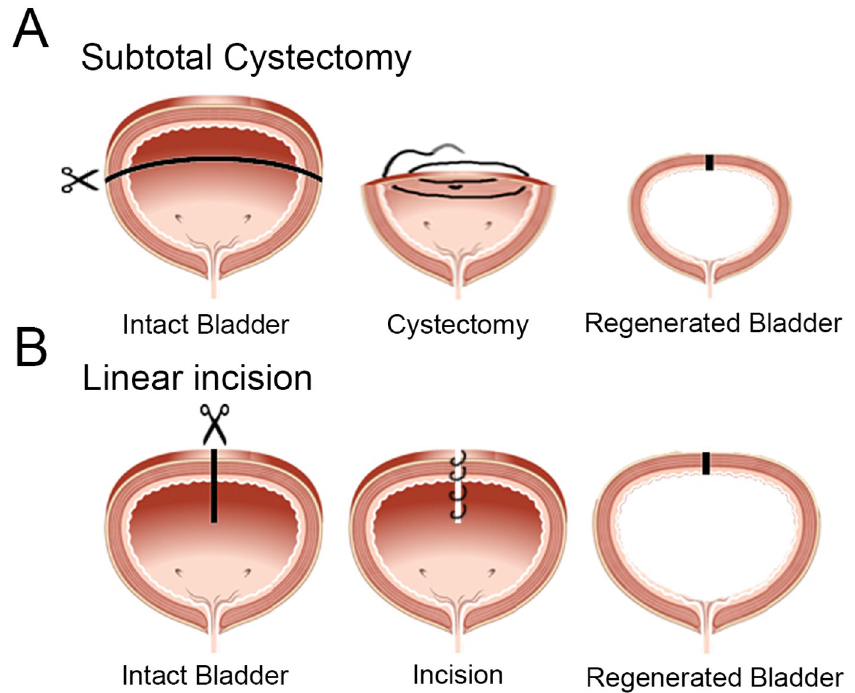
Fig 1. Strategy of the STC and subsequent analysis. (A) Schematic outlining how the STC surgery was performed and sutured. (B) Schematic indicating how the linear incision surgery was performed and sutured.